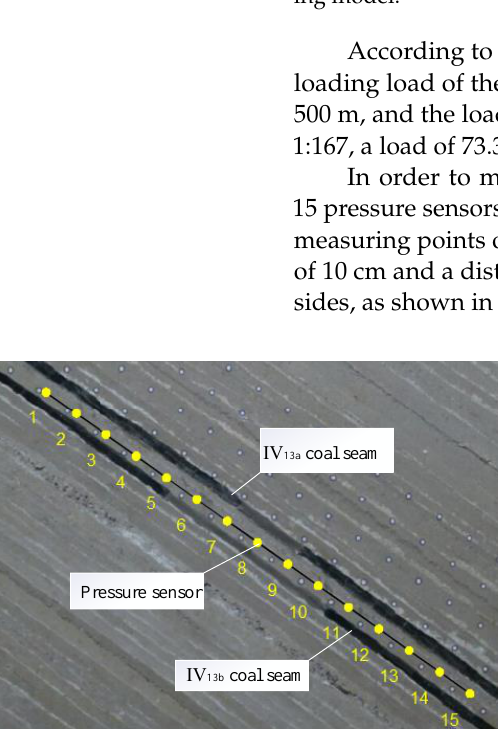
Figure 3. Construction of similar simulation experiment model. ( a ) Model design and size; ( b ) laying model.